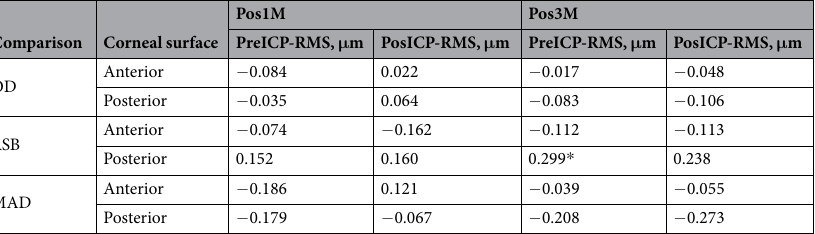
Table 6. The correlation result of PreICP-RMS and PosICP-RMS for anterior and posterior corneal surface with surgery parameters after correction of SE in different periods post LASIK (Pos1M and Pos3M). Pos1M means 1 month post LASIK, Pos3M means 3 months post LASIK; PreICP-RMS and PosICP-RMS represent the root- mean-square error of the coordinate differences of corneal surface between two successive measurement before and after topography matching, respectively; OD represents optical diameter, RSB means residual stromal bed thickness, MAD was maximum ablation depth and SE was spherical